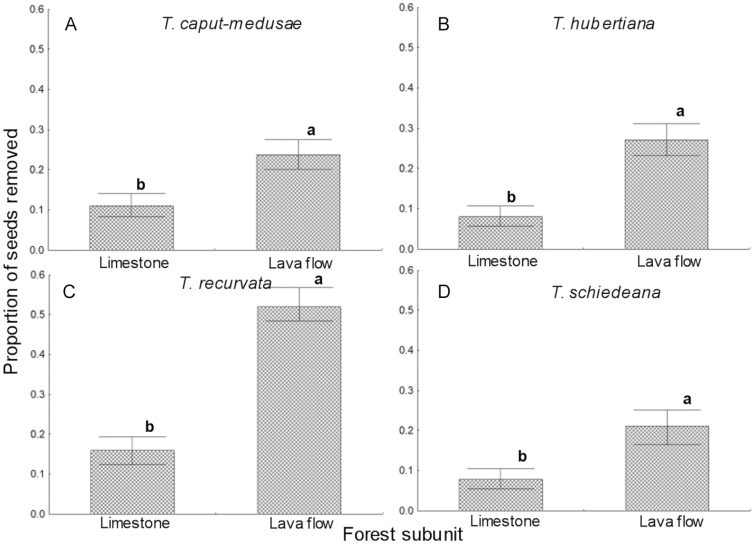
Proportion of seeds of four epiphyte species removed, according to the forest subunit (soils developed on limestone or on lava flow) where the six host tree species were selected in the tropical dry forest of San Andrés de la Cal, Tepoztlán, in Morelos, Mexico. Different letters denote significant differences in seed depredation among host species. The lines of dispersion are binomial 95 % confidence intervals.